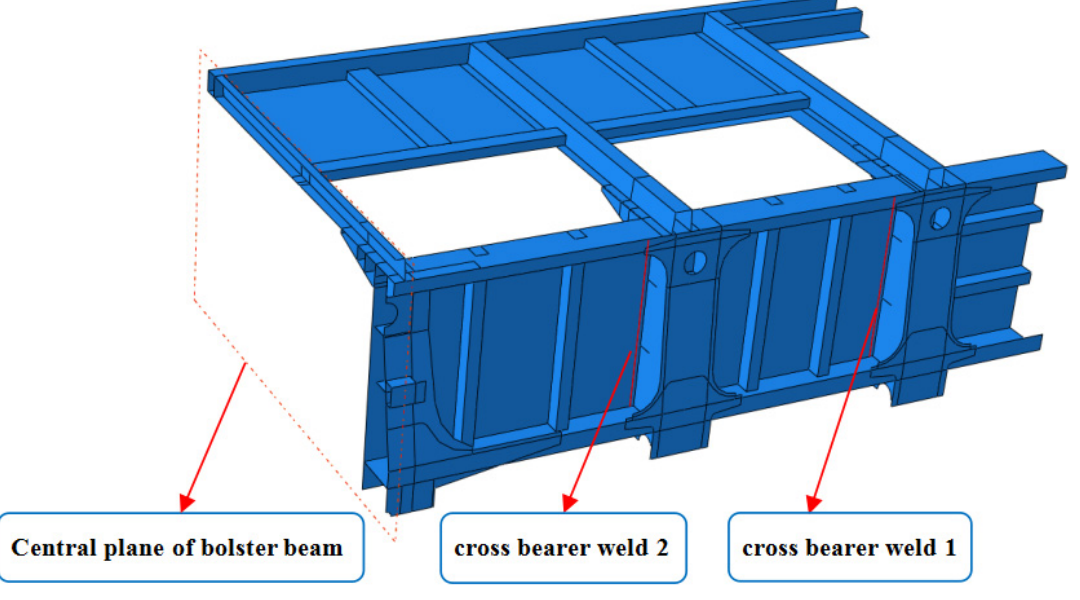
Figure 6. The local modal of car body.